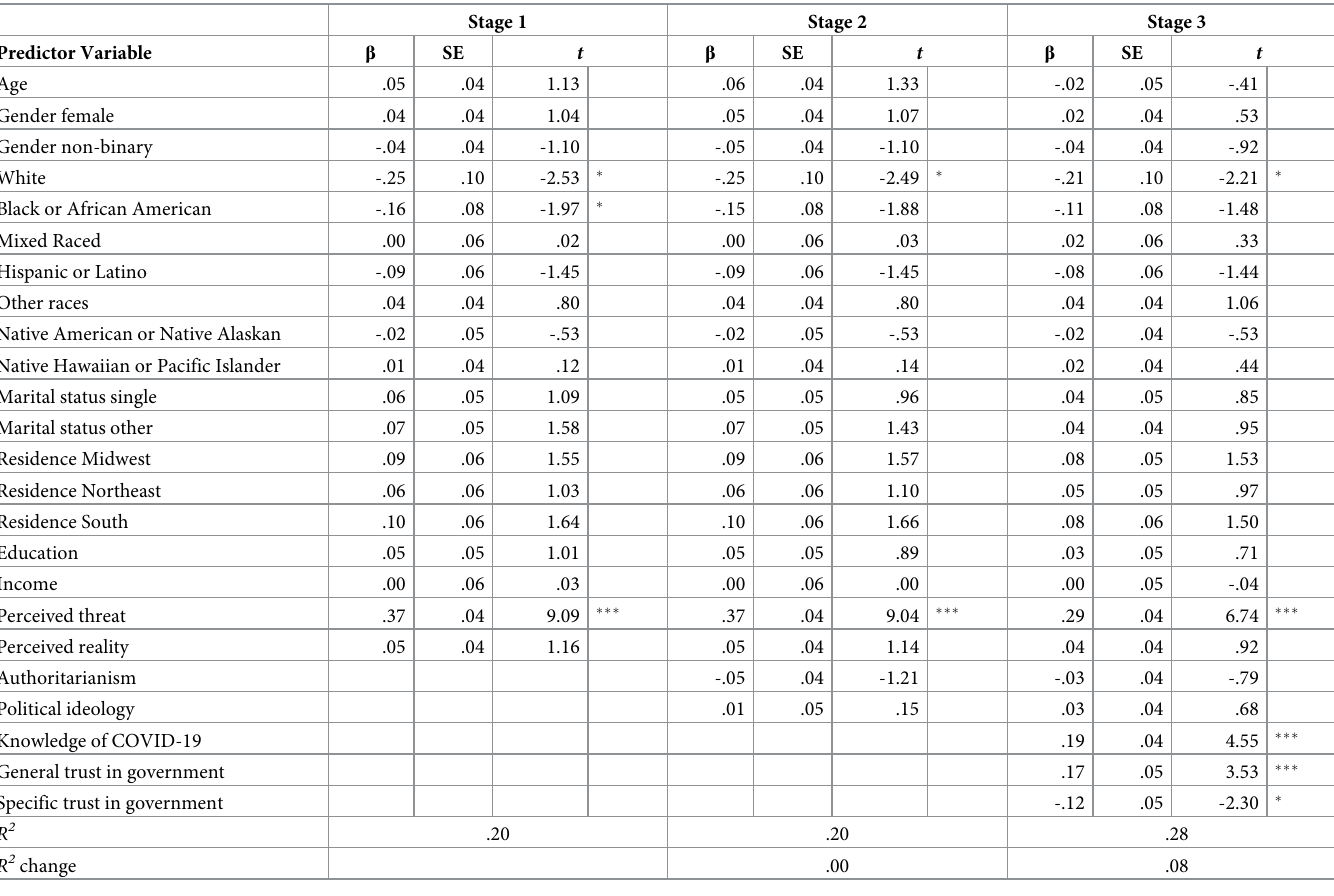
Table 5. Hierarchical regression analysis of predictors of mask-wearing (U.S.